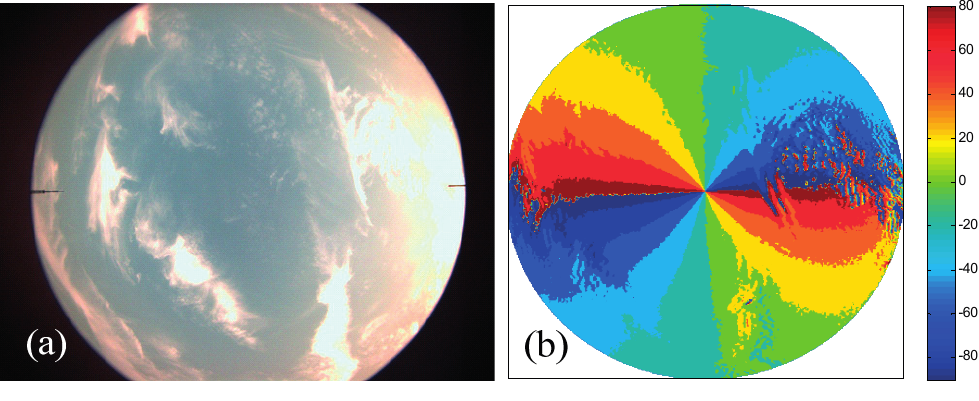
Figure 10. ( a ) Image of the cloudy sky; ( b ) Contour plot of measured ˆ φ of the cloudy